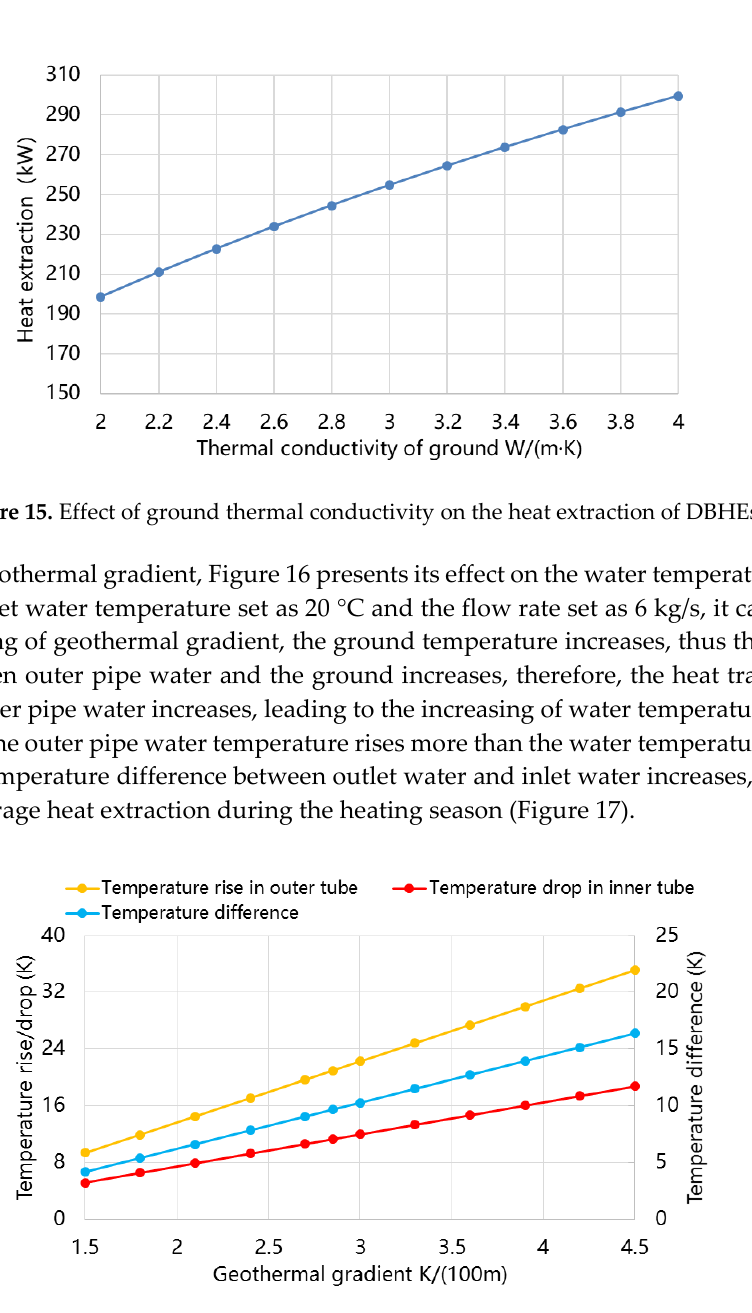
Figure 16. Effect of geothermal gradient on the water temperature